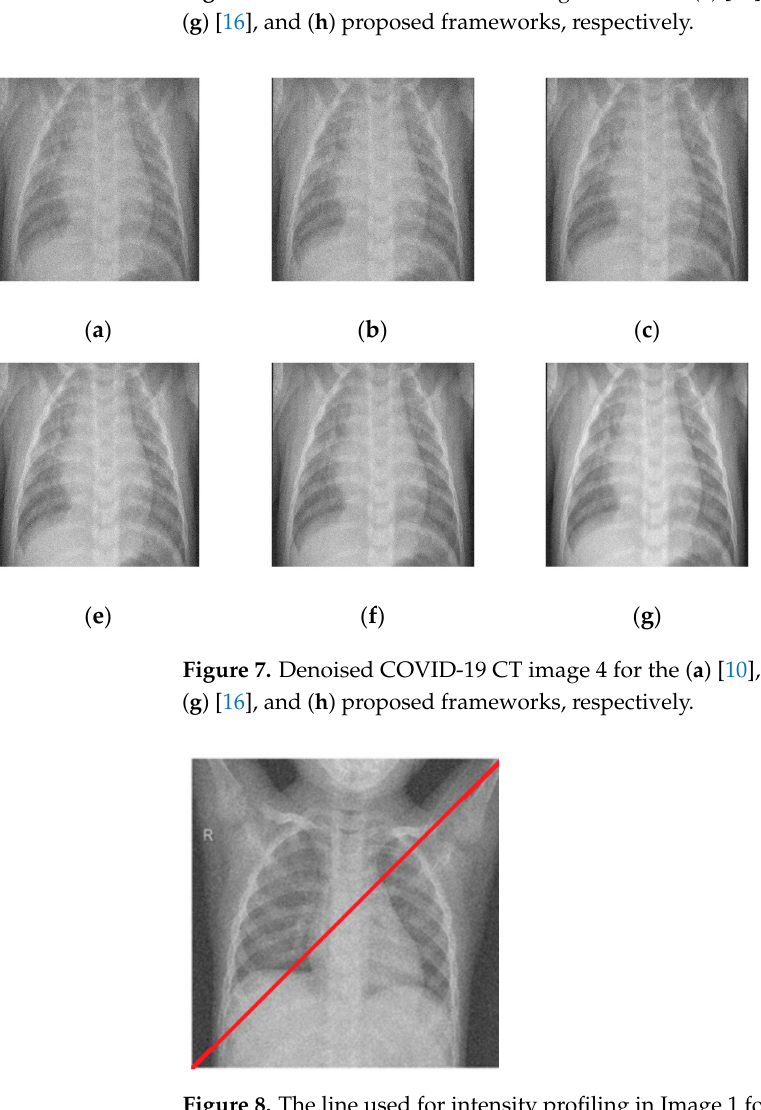
Figure 8. The line used for intensity profiling in Image 1 for all the frameworks.